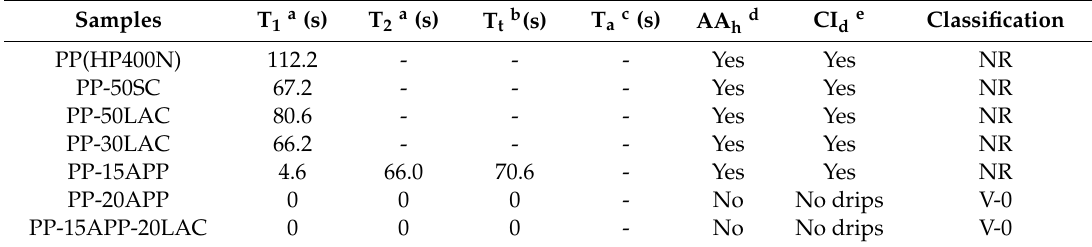
Table 5. UL-94 data of neat PP, PP–casein (LAC / SC), and APP samples.